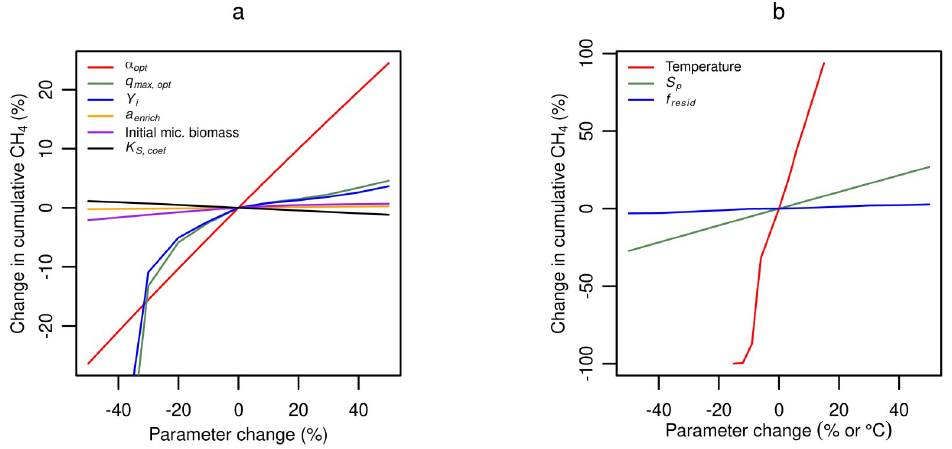
Fig 8. Model sensitivity to parameters and input variables. Model output sensitivities to (a) parameters and (b) input variables. Initial microbial biomass refers to changes in both the initial concentration of methanogens in the slurry inoculum and the fresh influent slurry. For parameter values, see S3 Appendix.